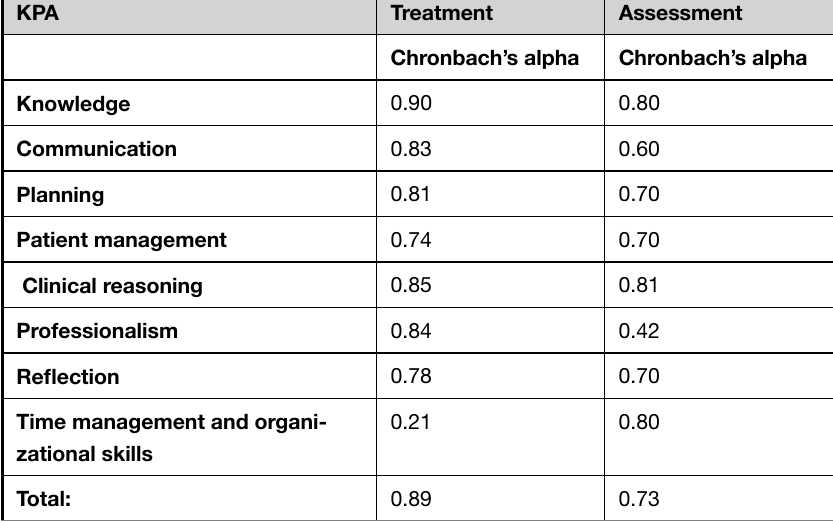
Table 1: internal consistency scores per key performance area for the treatment and assessment examinations.